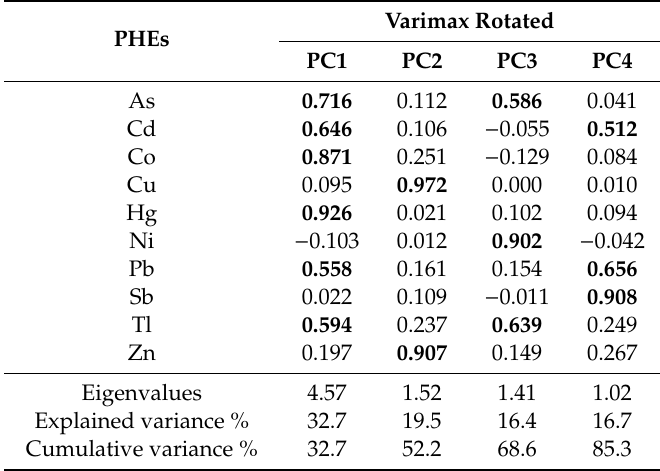
Factor loadings exceeding 0.5 are shown in